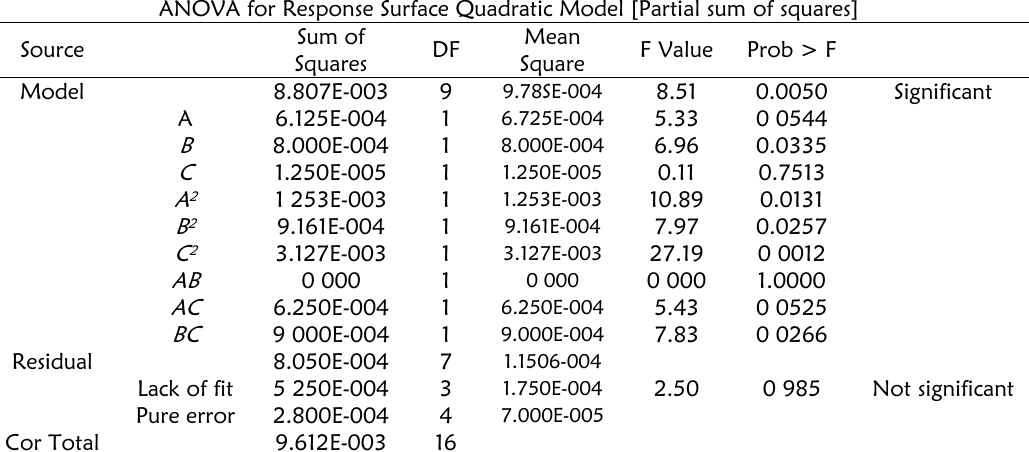
Table 3: ANOVA for Response R a